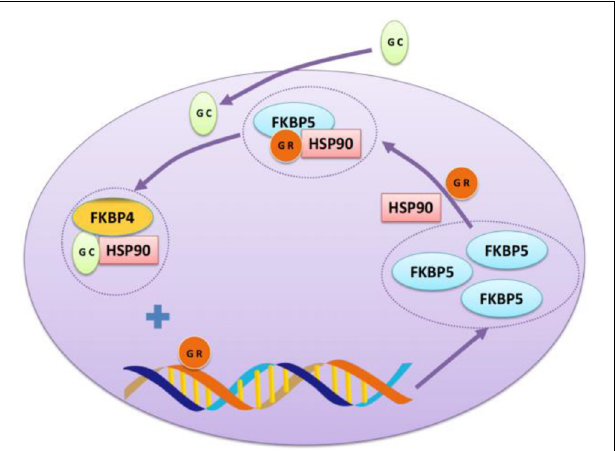
FIGURE 2 | The interaction between GR and FKBP5. Glucocorticoid receptor (GR) can form a chaperone complex with FKBP5 and heat shock protein 90 as an intracellular receptor to prevent GR from being transported to the nucleus. After binding glucocorticoid (GC), GR dissociates and binds to the fkkbp5 enhancer-binding site, produces more FKBP5, conducting a negative feedback